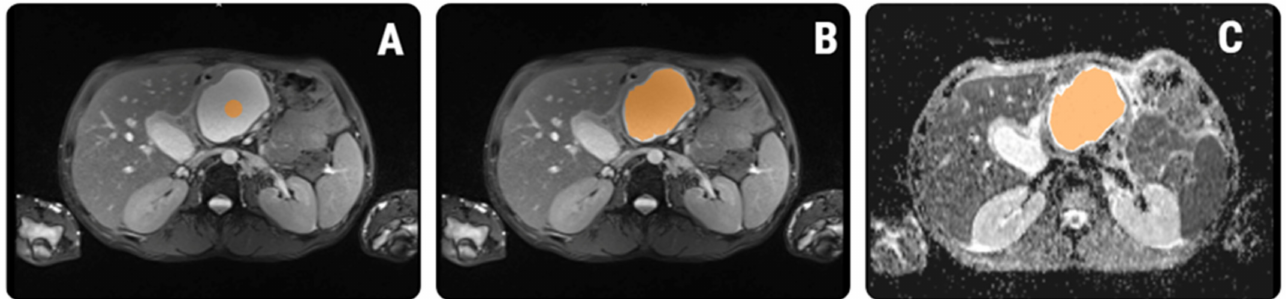
Figure 2. ROI definition within the texture analysis software. ( A ) A seed was placed on the T2- weighted image (orange round dot); ( B ) the software automatically grew the seed based on intensity and gradient coordinates (orange); ( C ) after extracting the features from the T2-weighted image, the ROI was transferred to the corresponding ADC map and manually adjusted